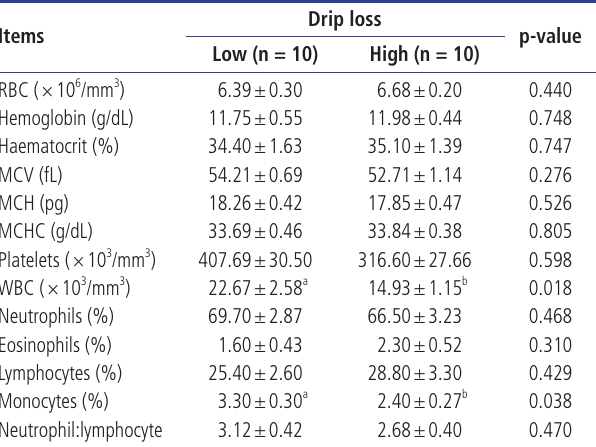
Table 2. Influence of drip loss on blood haematological parameters in pigs